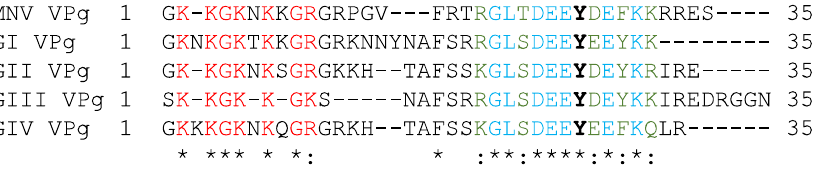
Figure 7. Alignment of VPg sequences. An asterisk (*) indicates identical residues and a colon (:) indicates residues that are similar. Conserved amino acids of the N-terminal region are shown in red. The tyrosine residue (Y) corresponding to Y26 of MNV VPg is shown in black in bold. The fully conserved amino acids surrounding the Y26 are shown in blue and similar amino acids in green. The represented genogroups are GI Norwalk virus VPg (AAC64602), GII Sydney 2012 VPg (JX459908), GIII Jena virus VPg (CAA90480) and GIV Lake Macquarie VPg